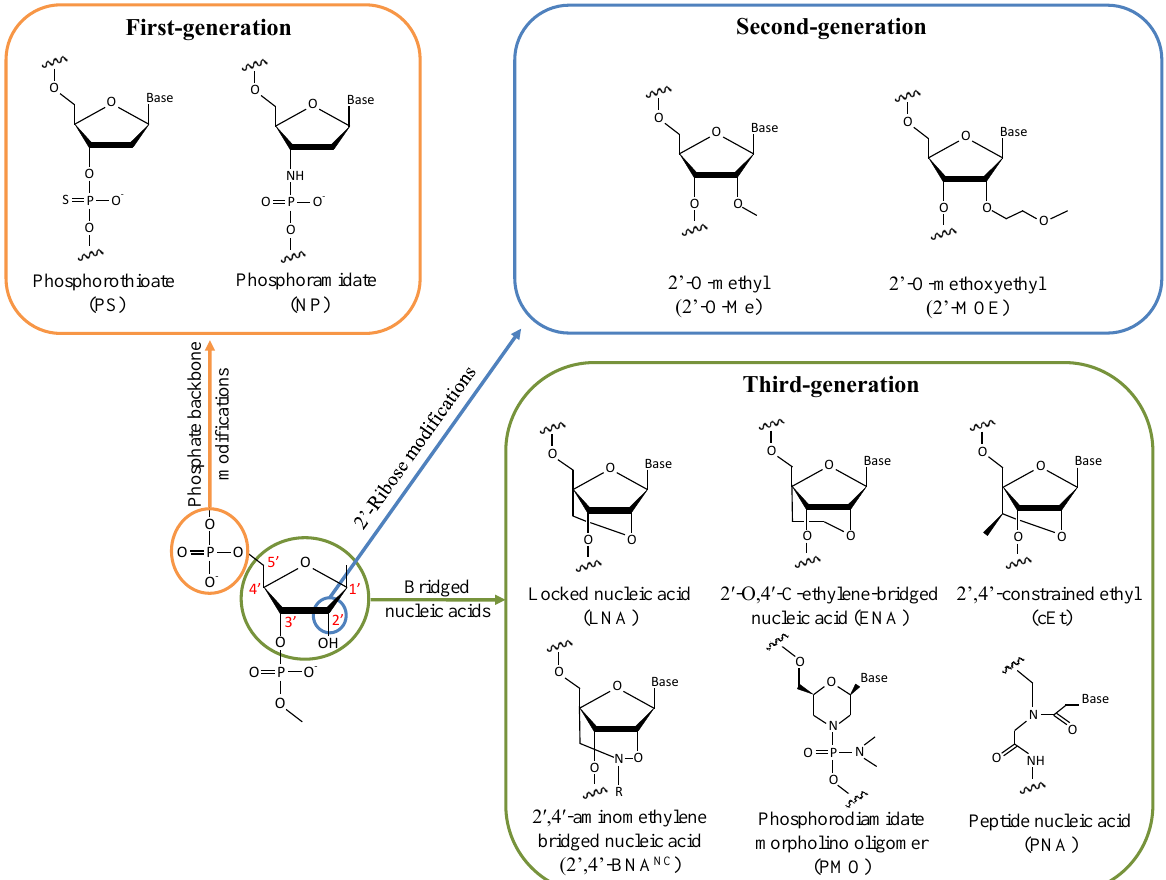
Figure 1. Chemical modifications of the sugar-phosphate backbone of ASOs that have been investi- gated for treating